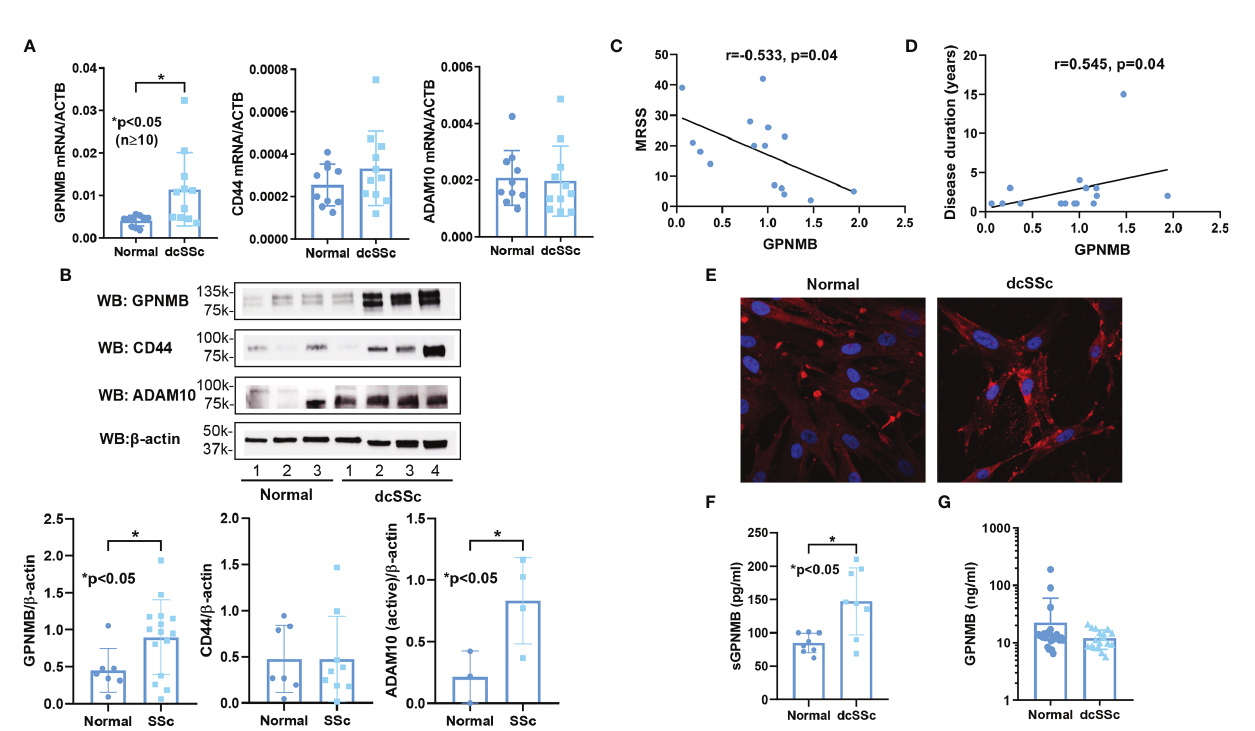
FIGURE 1 | GPNMB, CD44, and ADAM10 expression in normal and dcSSc fi broblasts. (A) GPNMB mRNA levels were signi fi cantly upregulated in dcSSc fi broblasts compared to healthy controls, while CD44 and ADAM10 levels were similar. (B) At the protein level, differences in CD44 did not reach statistical signi fi cance, while GPNMB and ADAM10 were signi fi cantly increased in dcSSc fi broblasts. (C) GPNMB protein levels in dcSSc fi broblasts negatively correlated with the modi fi ed Rodnan skin score (MRSS). (D) GPNMB protein levels in dcSSc fi broblasts positively correlated with disease duration. (E) Immuno fl uorescence staining of GPNMB in both normal and dcSSc fi broblasts showed that GPNMB was widely expressed in the cytosol. In dcSSc fi broblasts GPNMB showed prominent staining at the plasma membrane. (F) The soluble form of GPNMB was signi fi cantly higher in culture media from dcSSc fi broblasts compared to healthy controls. (G) Serum levels of sGPNMB were similar between healthy controls and dcSSc patients. n=number of subjects. Results are expressed as mean +/- SD and p < 0.05 was considered signi fi